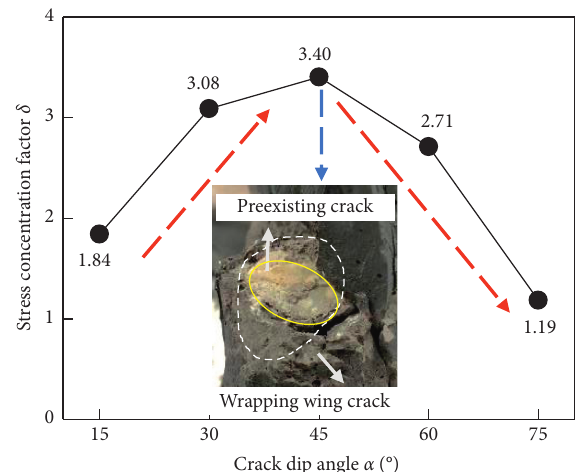
Figure 9: Variation of stress concentration factors δ with crack angles α